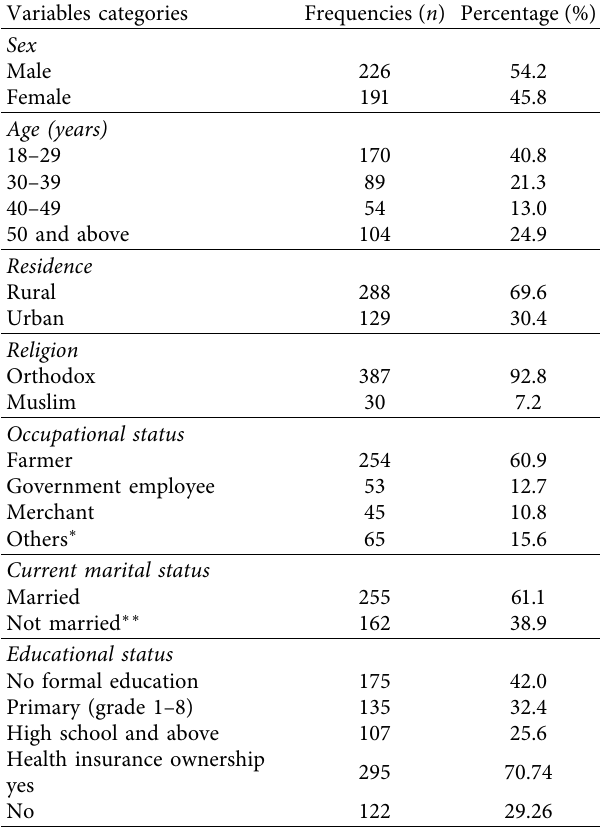
Table 2: Patient-related characteristics of the study participants ( n �